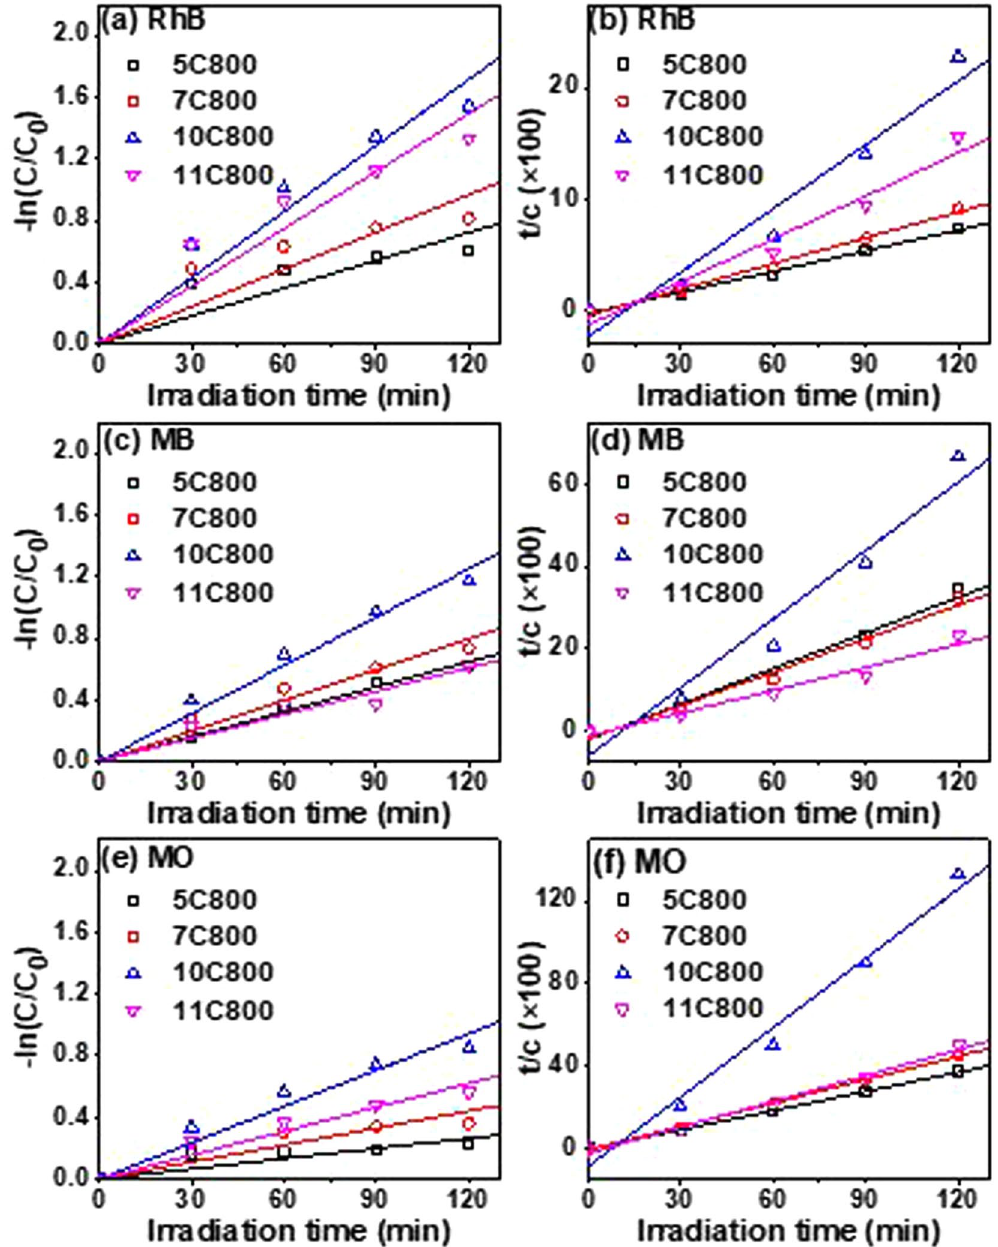
Figure 12. First order kinetics ( a , b , c ) and second order kinetics ( b , d , e ) of dyes with all the samples synthesized at 800 °C of ( a ) RhB, ( b ) MB and ( c )